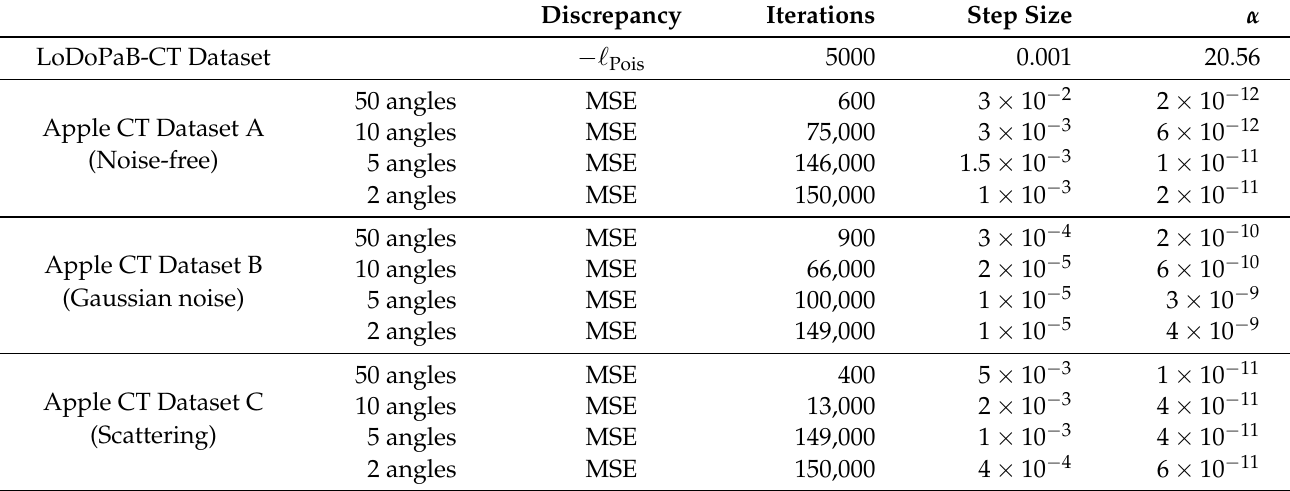
Table A2. Hyperparameters for total variation regularization (TV).